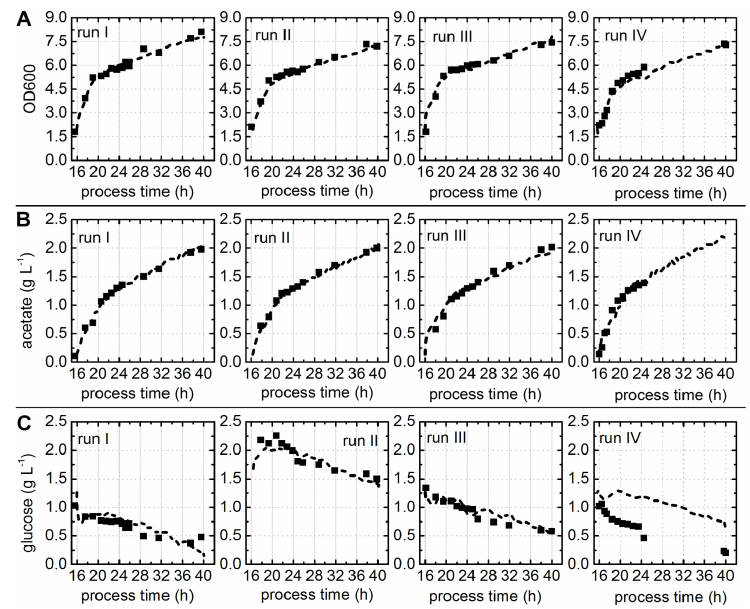
Figure 3 . Correlation of predicted and offline measured process parameters. Predicted values (dashed) were compared to offline values (squares). Runs I–III were used for calibration and internal cross-validation of the soft sensors predicting OD 600 ( A ), acetate ( B ), and glucose concentrations ( C ). Run IV was not included in model generation; this cultivation was used to test the selected